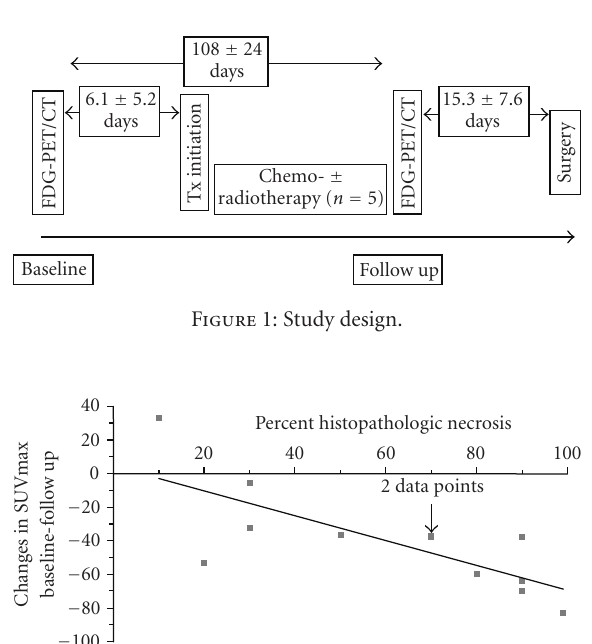
Figure 2: Changes in SUVmax from baseline to late followup are significantly correlated with percent of histopathologic necrosis in the excised tumor tissue (Pearson Correlation Coe ffi cient = − 0 . 75; P = .